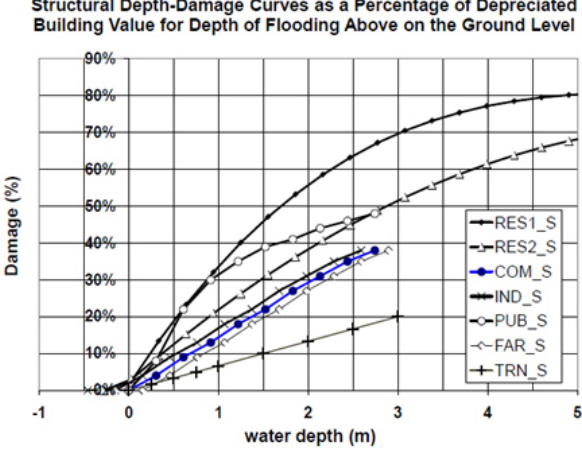
Table 3. Assigning occupancy type from zoning